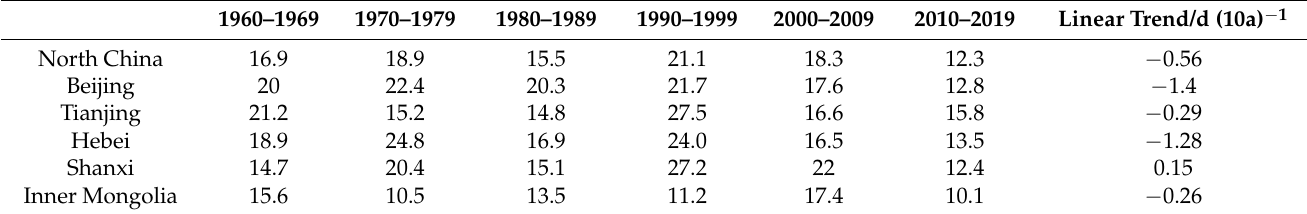
Table 4. Decadal average and linear trend rate of severe drought and above days for North China.